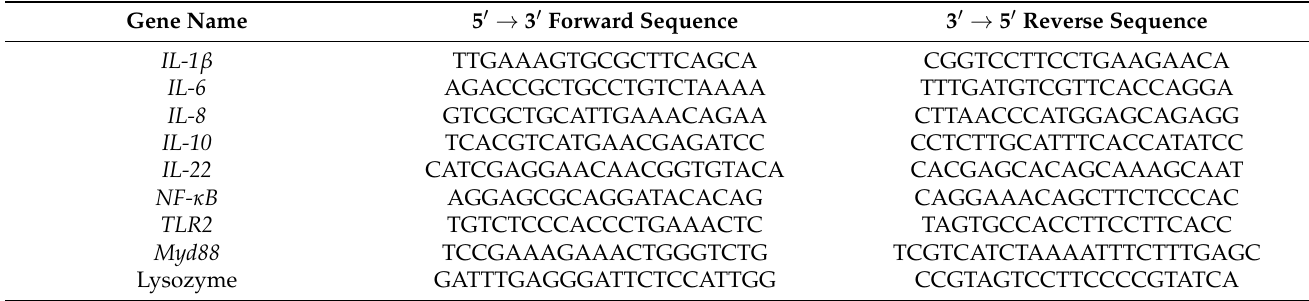
Table 2. Primers for